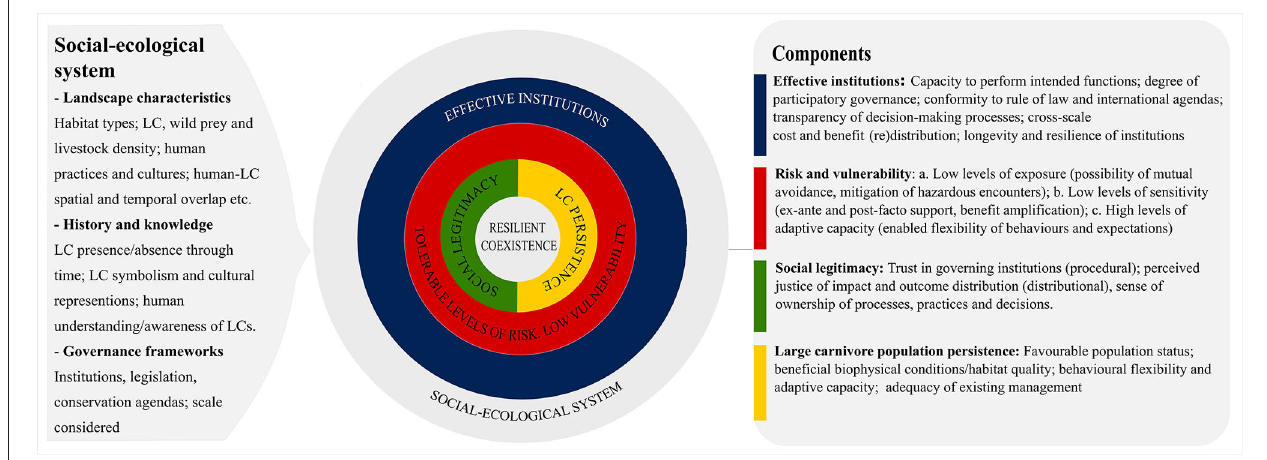
FIGURE 1 | Schematic illustration of the conditions of resilient coexistence with large carnivores (LCs) within a given system. Synergies within the model can work in both directions: Institutions can mediate the influence of social and ecological processes on human and wildlife communities, and ensure that human-LC interactions are not undermining the integrity of the ecological and cultural